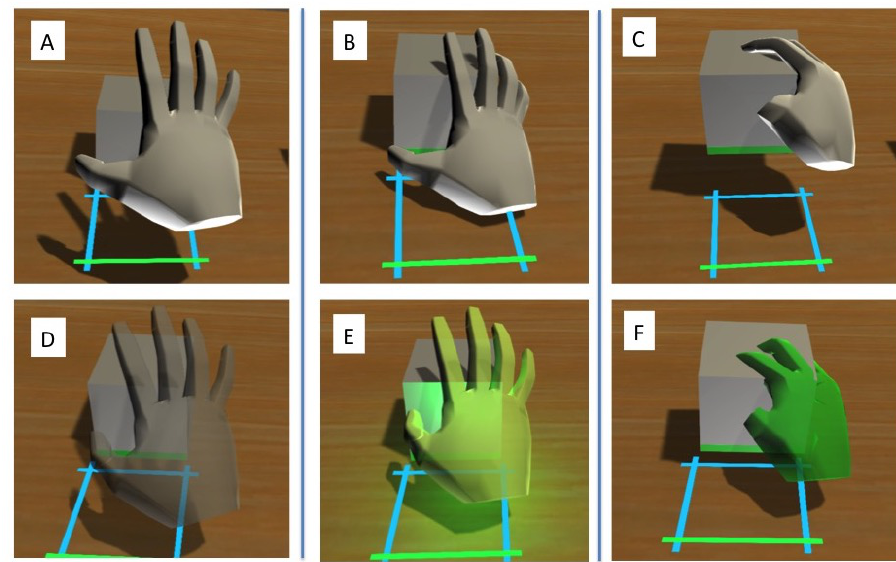
Figure 1. Differences in hand representations between Basic Leap (B_Leap- A – C ) and HHI Modified Leap (HHI_Leap- D – F ). A / D : Open hand, not within grabbing range. B / E : Open hand, within grabbing range. C / F : Gripping